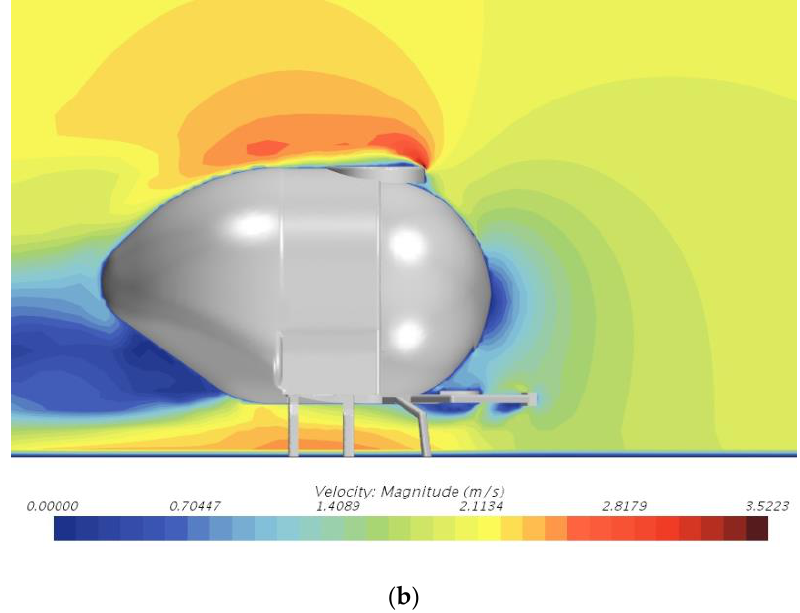
Figure 18. UMSWR analysis in shallow water. ( a ) Velocity and pressure distribution. ( b ) Velocity variation.